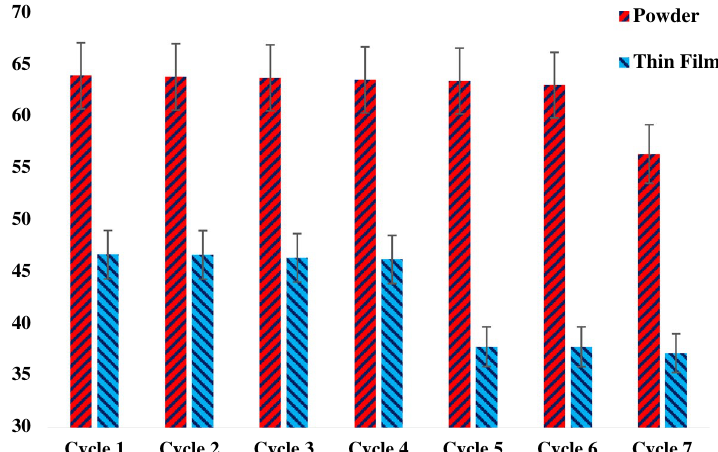
Figure 14. The reusability process for both thin film/FTO substrate and powder